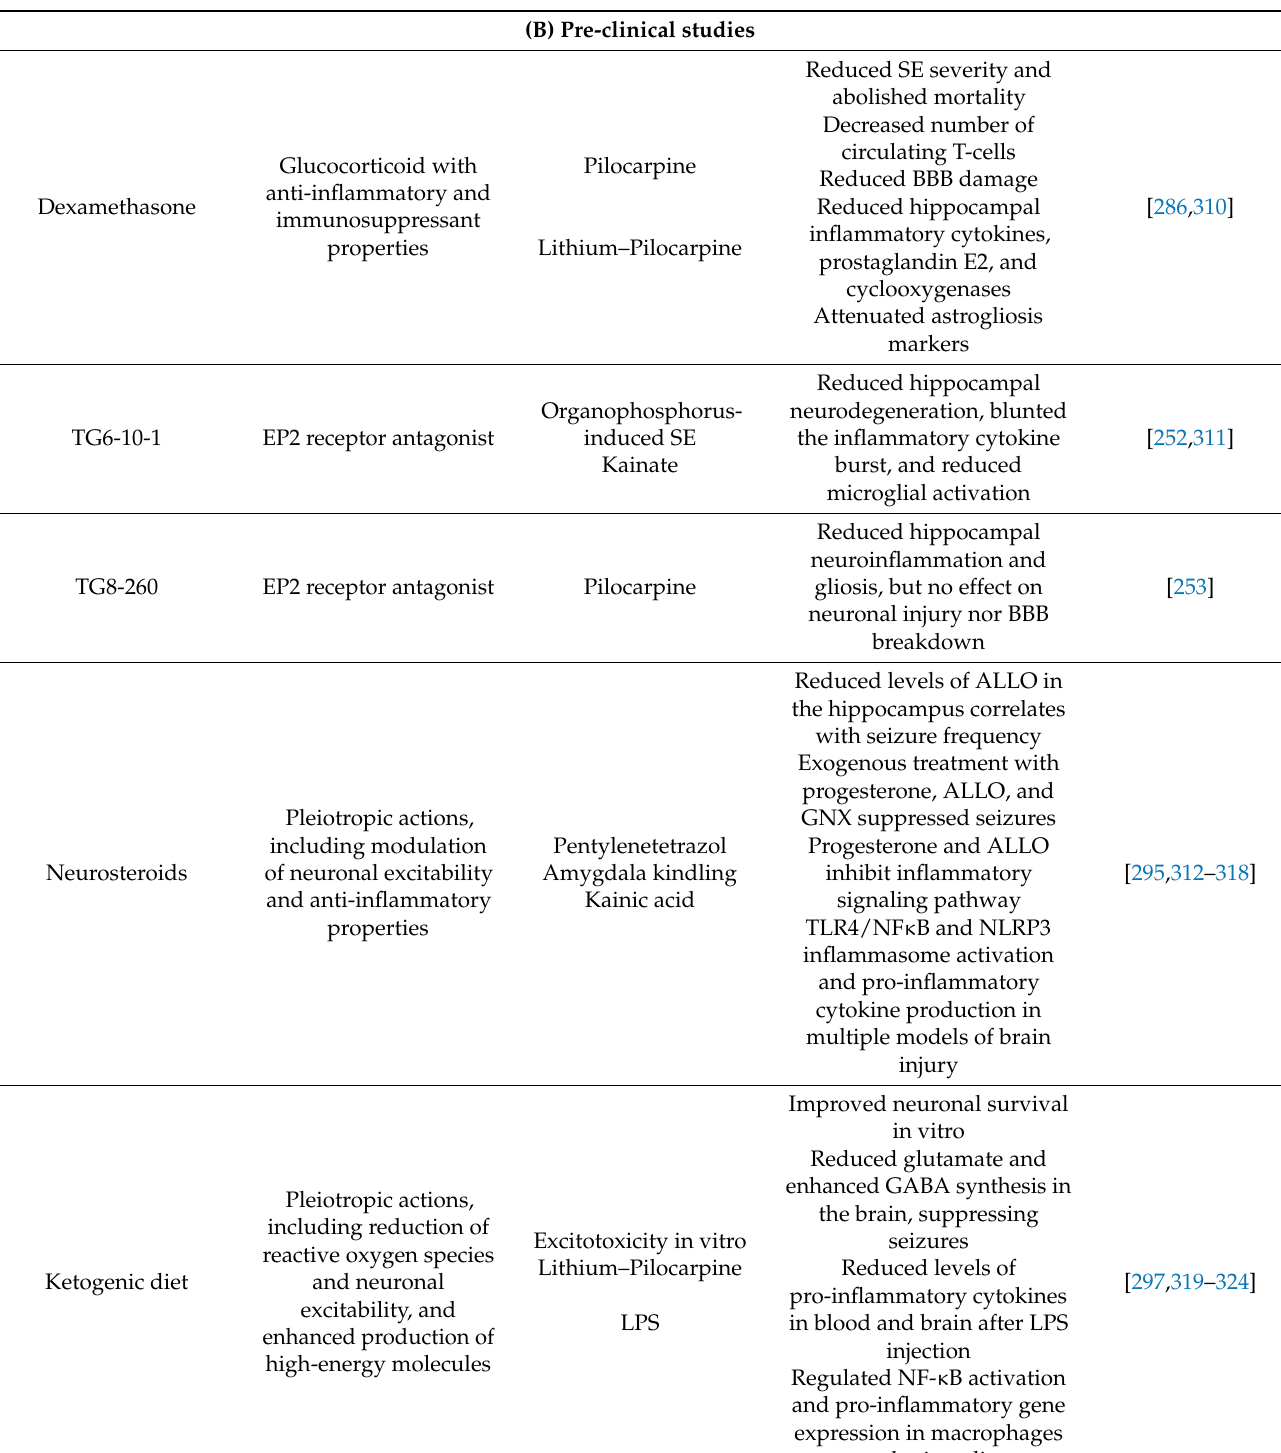
Table 1. Cont. (B) Pre-clinical